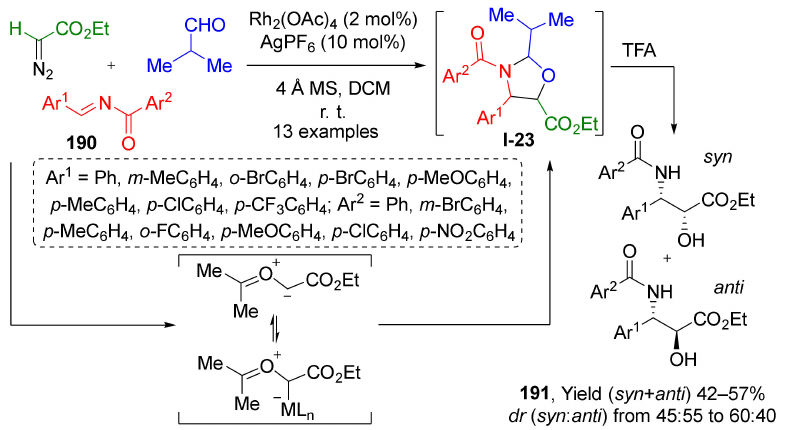
In some cases, [3+2]-cycloaddition strategy can be used for the preparation of acyclic molecules, when initial cyclic products are labile compounds. This principle was employed by W. Hu et al. to access α -hydroxy- β -acylamino esters 191 via Rh/Ag-catalyzed cycloaddi- tion of carbonyl ylides and various aldehydes followed by acid hydrolysis of intermediate oxazolidines I-23 (Scheme 55) [63]. Ylides were generated in situ from N -acylimines 190 and ethyl diazoacetate at room temperature. The hydrolysis was performed in a one-pot fashion upon treatment with TFA after completion of the cycloaddition step. The reaction was found to be rather general and compatible with different types of substituents but suffered from moderate yields and poor diastereoselectivity.